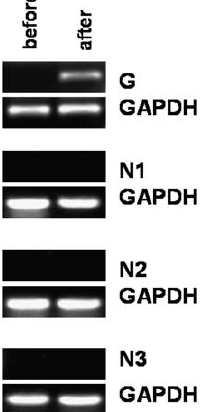
Fig. 2C. The induction of human IL-13Ra2 transcript G expression in K562 cells with the stimulation by PMA/Ionomycin. No expres- sion of transcripts N1, N2 and N3 was found after the stimulation. Primers for human GAPDH gene were used as positive control. Wa- ter without template was used as the negative control. The figure is representative of 3 independent